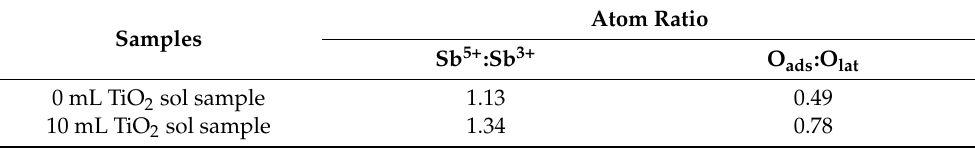
Table 2. Calculated atom ratios for Ti/SnO 2 -Sb 2 O x and Ti/SnO 2 -Sb 2 O x -TiO 2